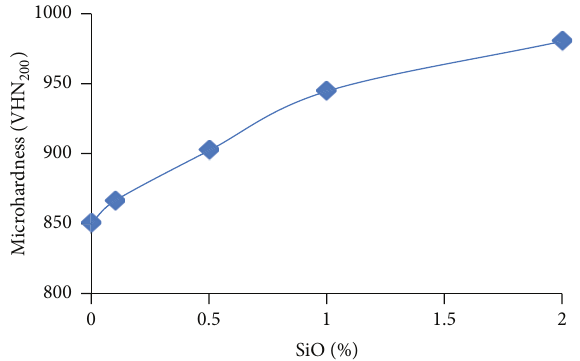
Figure 16: Variation in specific wear rate of EN-coatings as a function of SiO with surfactant (SLS) in EN